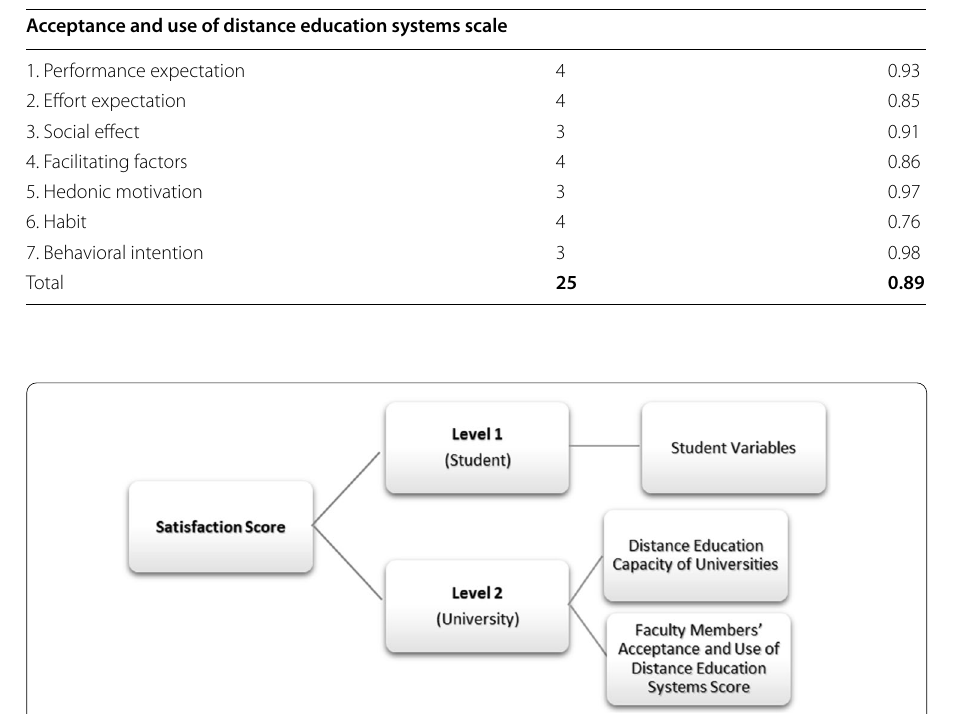
Fig. 1 Conceptual framework of the